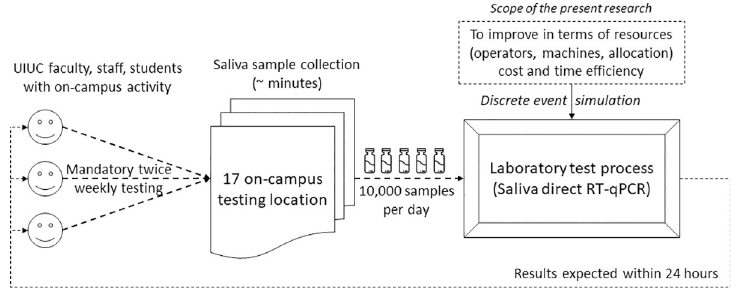
Fig 1. COVID-19 testing workflow at the University of Illinois at Urbana-Champaign